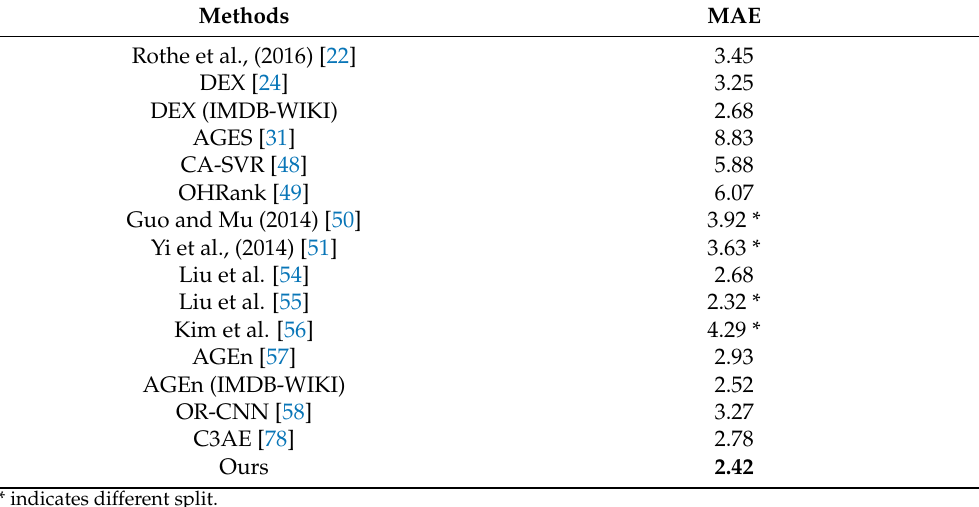
Table 5. Result (MAE) comparison for real (biological) age estimation for the Morph dataset.